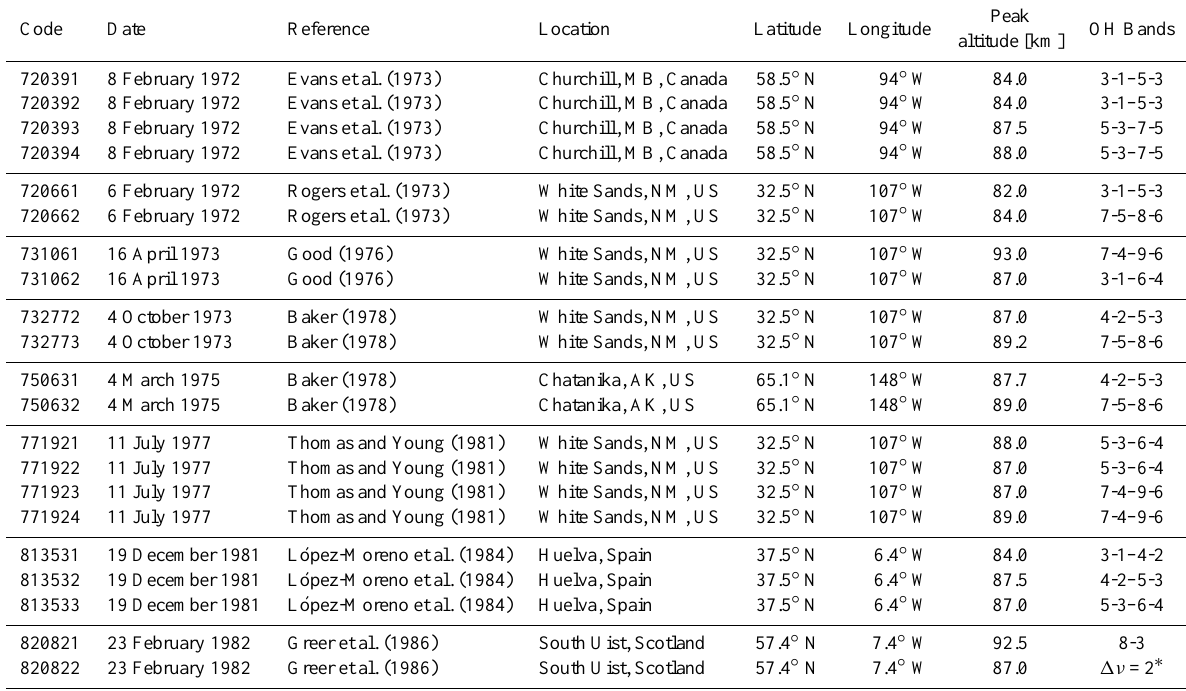
Table 2. Compilation of rocket OH profile measurements listed in Table V of Baker and Stair (1988) that cover different OH Meinel bands